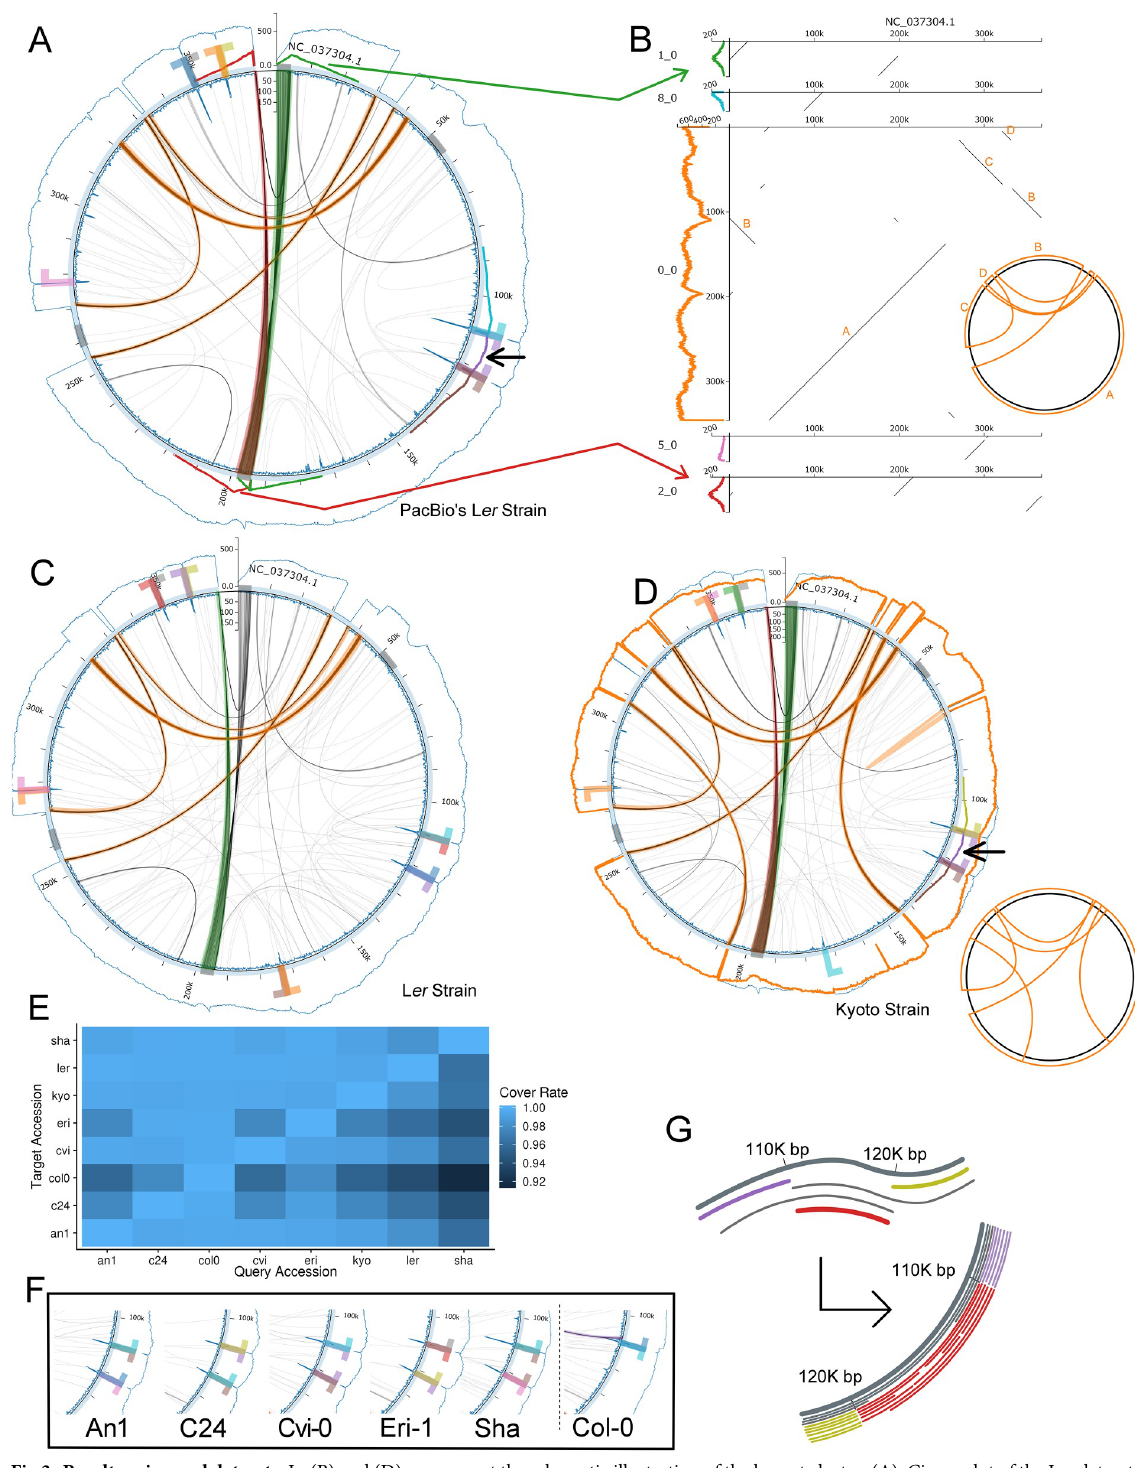
Fig 3. Results using real datasets. In (B) and (D), we present the schematic illustration of the largest cluster. (A): Circos plot of the L er dataset from PacBio’s official repository. (B): Dot plots between the assembled contigs from the L er dataset from PacBio’s official repository and the reference contig. Colored arrows indicate the correspondences between clusters and contigs. We plotted five assembled contigs from 12 clusters due to space limitations. (C): Circos plot of the L er dataset from [31]. (D): Circos plot of the Kyoto strain on Col-0’s master circle. (E): Cover rate associated with each pair of accessions. (F): Linear structures observed in the remaining datasets–i.e., An1, C24, Cvi-0, Eri-1,